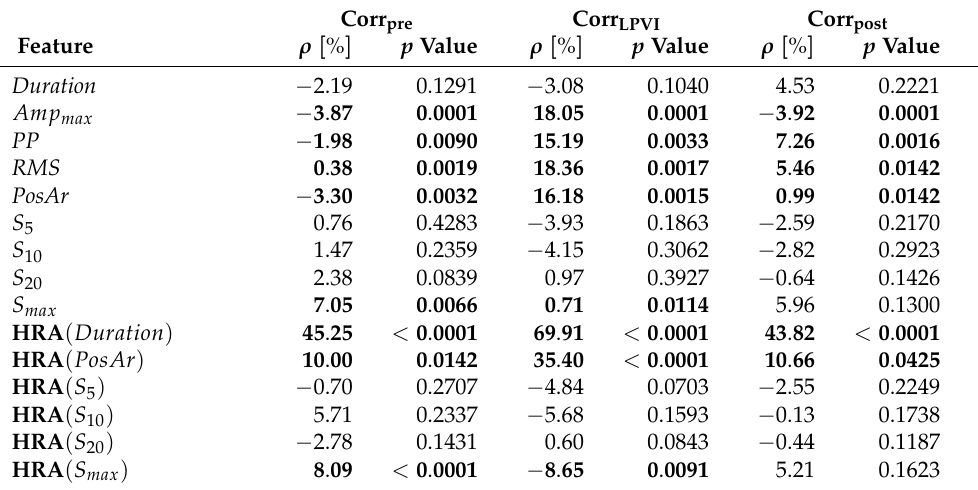
Figure 3. Pearson correlation between surface and invasive features of each activation, measured before CA (red), after LPVI or during CA (green), and after the end of the CA procedure (blue). Statistically significant results are marked with an asterisk ( ∗ ). Table 1. Correlations (%) and p values for Pearson analysis between surface and invasive features for each and every activation. Statistically significant results are shown in bold . LPVI: left pulmonary vein isolation; PP : peak-to-peak amplitude; RMS : root mean square; S i : Slope rate at i % of Duration